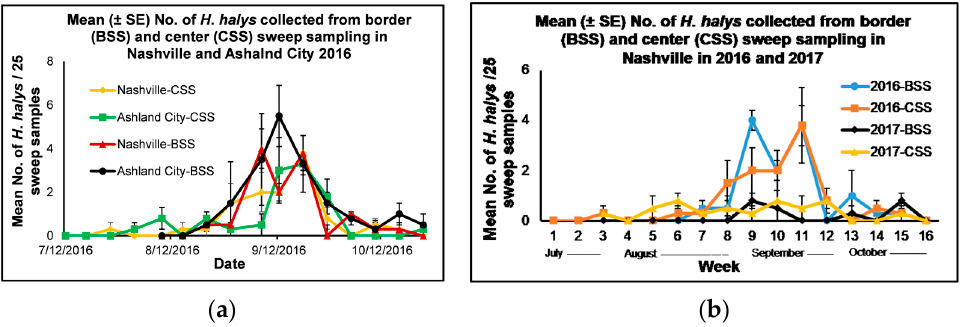
Figure 1. Mean (±SE) number of adult and immature Halyomorpha halys per 25 sweep samples/block collected from border and center sweep sampling in soybeans from ( a ) July to October 2016 con- ducted in Ashland City (Cheatham County) and Nashville (Davidson County), Tennessee ( b ) July to October 2016 and 2017 conducted in Nashville (Davidson County), Tennessee. Week 1: 7/12/2016 or 7/11/2017, week 2: 7/19/2016 or 7/18/2017, week 3: 7/26/2016 or 7/25/2017, week 4: 8/03/2016 or